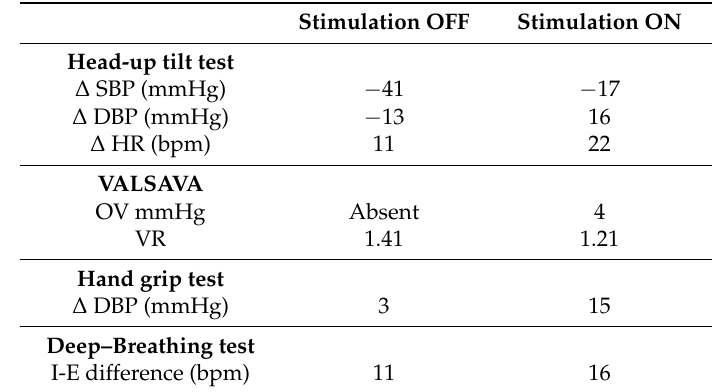
Table 3. Effects of burst high cervical spinal cord stimulation (B-HCSCS) on the patient suffering autonomic nervous system